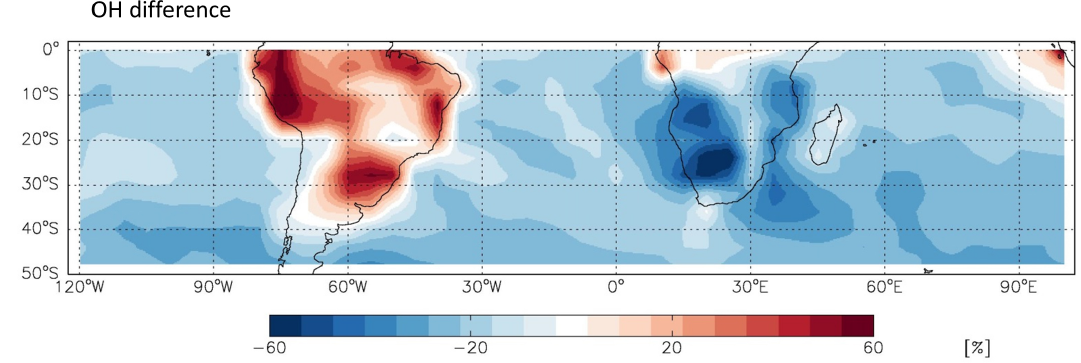
Figure 11. Percentage difference of boundary-layer OH between present and future over tropical areas and SH in